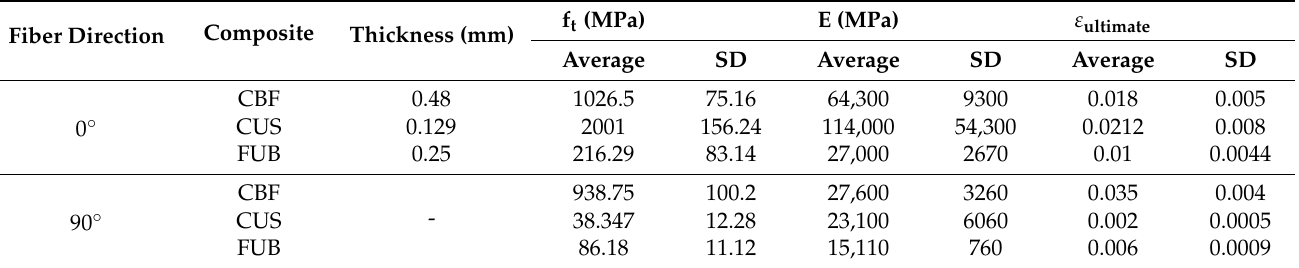
Table 3. Composites tensile